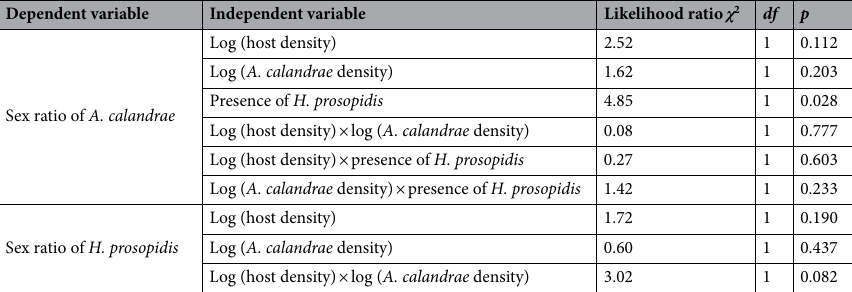
Dependent variable Independent